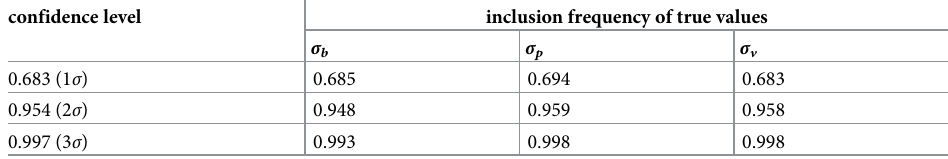
Table 2. The inclusion frequency of true values evaluated by Monte Carlo simulation at three confidence levels for the optimized protocol. confidence